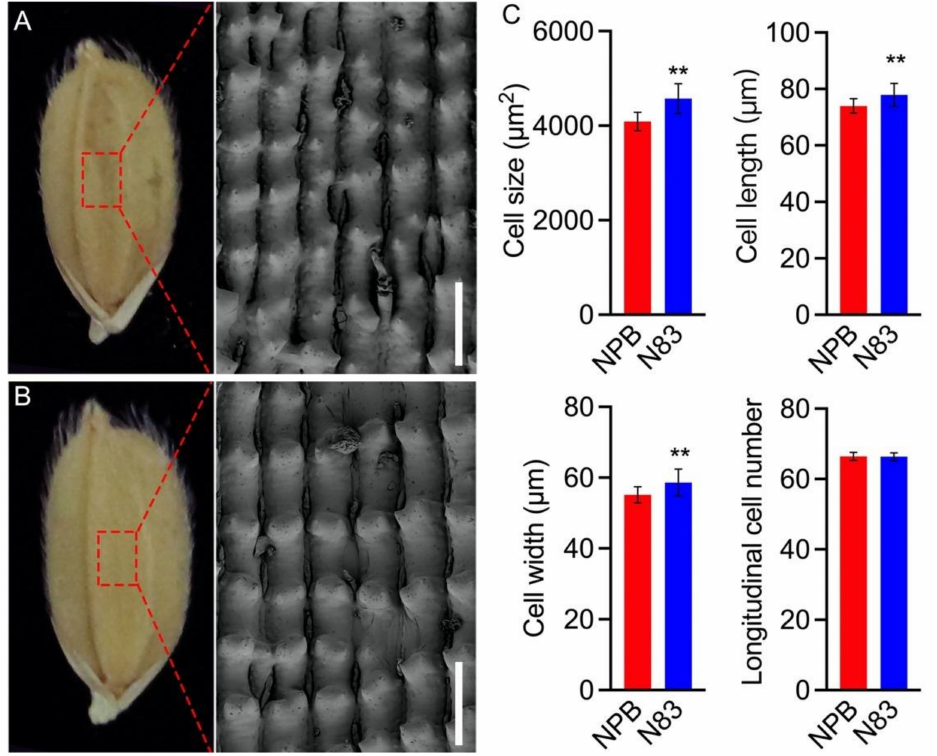
Figure 3. Images of spikelet outer epidermal cells were obtained by SEM in NPB ( A ) and N83 ( B ). Scale bars, 100 µ m. ( C ) Comparisons of cell size, length, width, and longitudinal cell number of the spikelet hulls in NPB and N83. Data in ( A ) ( n = 30) are means ± SD, ** p < 0.01. Student’s t -test was used to generate the p